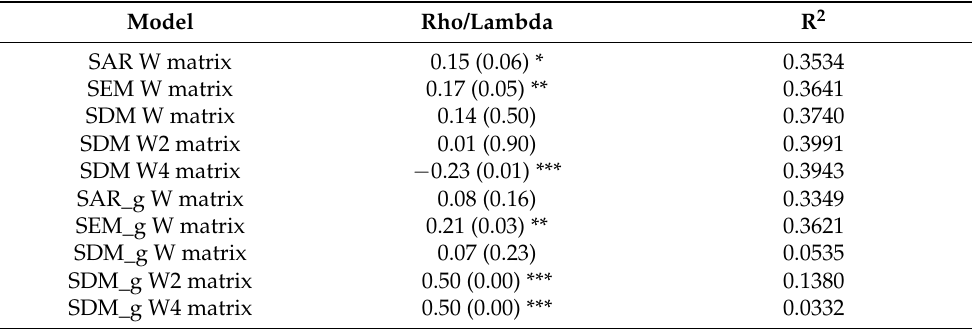
Table 4. Spatial Models